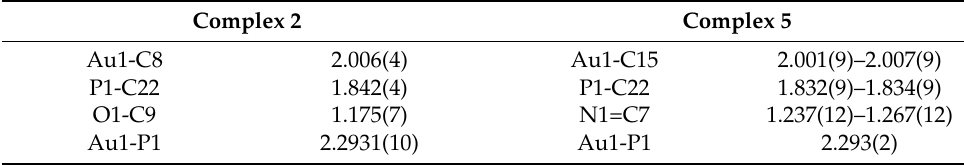
Figure 5. Crystal structures of 2 ( left ) and 5 ( right ). Table 1. Bond lengths (Å) for complexes 2 and